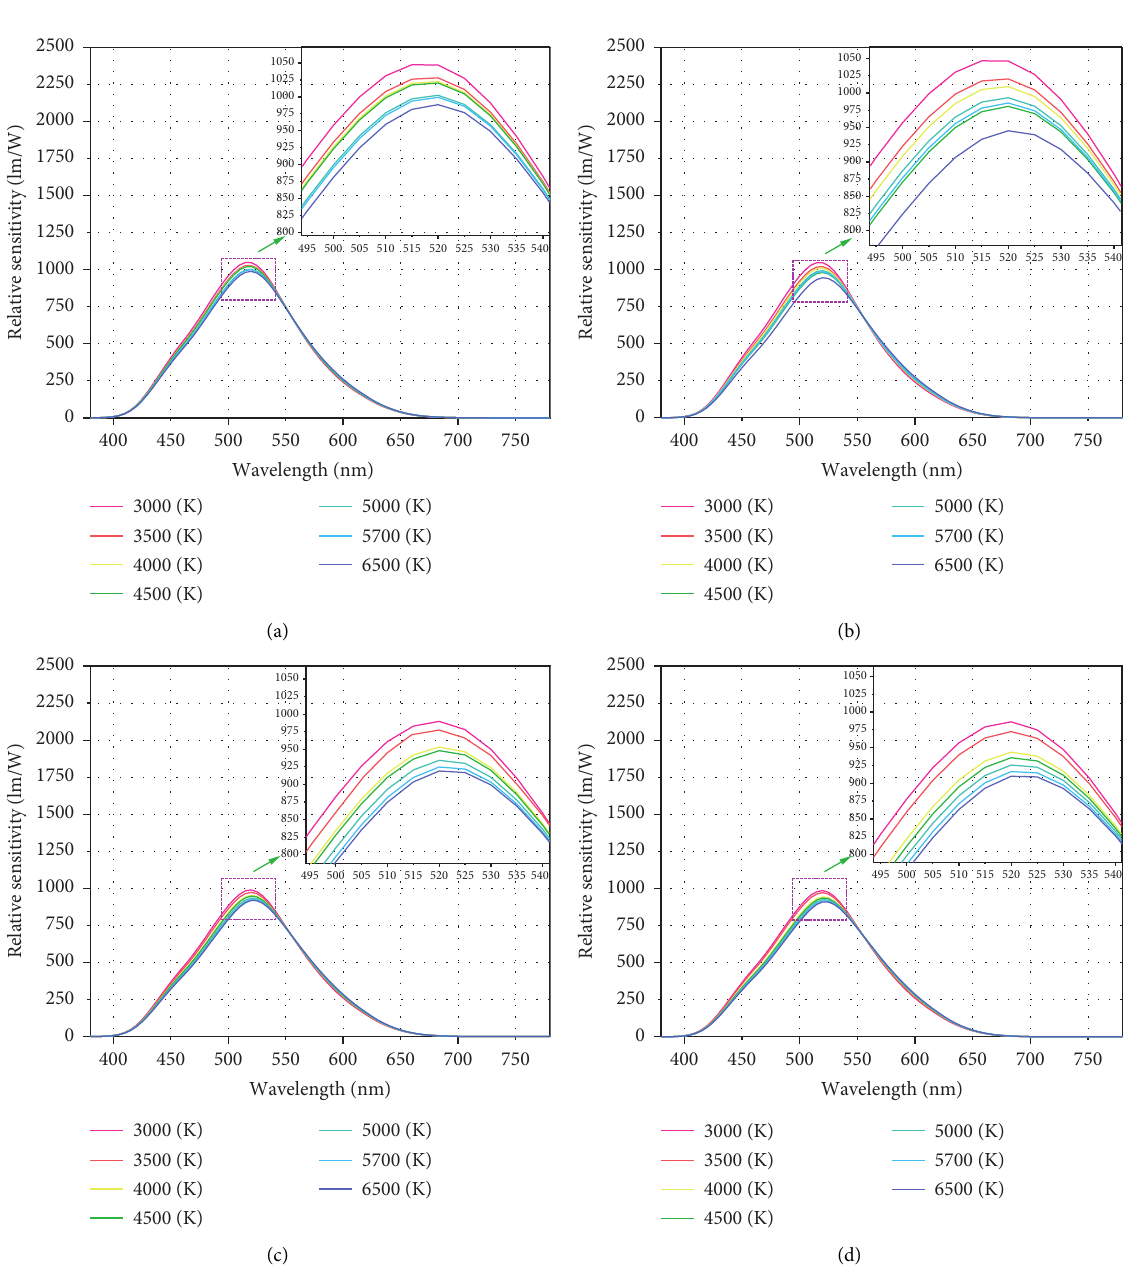
Figure 3: Mesopic spectral luminous efficiency. (a) CRI2012 � 65. (b) CRI2012 � 75. (c) CRI2012 � 85. (d) CRI2012 �